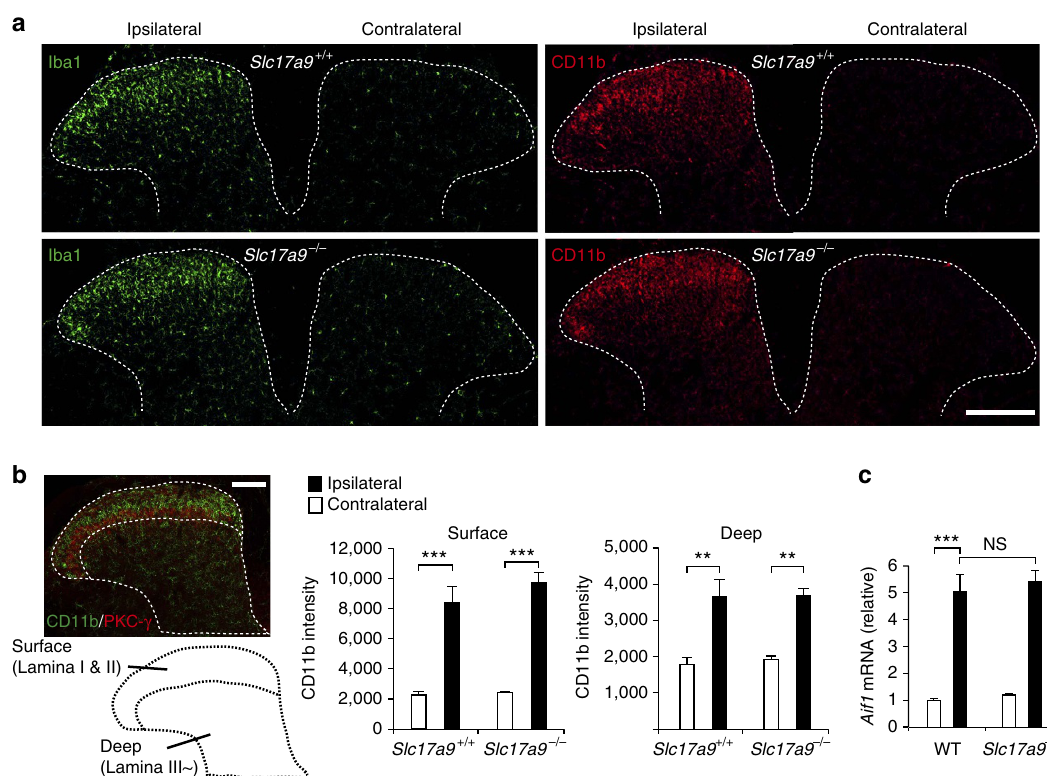
Figure 4 | VNUT is not required for PNI-induced cellular alterations of spinal microglia. ( a ) Representative images showing immunofluorescence labelling of Iba1 (green) and CD11b (red) in the L4 spinal cord of Slc17a9 (cid:2) / (cid:2) and Slc17a9 þ / þ mice 7 days after PNI (scale bar, 200 m m). ( b ) The intensity of CD11b immunofluorescence was quantified for the surface (lateral side of PKC- g signals) and deep (medial side of PKC- g signals) dorsal horn region of Slc17a9 (cid:2) / (cid:2) and Slc17a9 þ / þ mice 7 days after PNI ( n ¼ 4; ** P o 0.01, *** P o 0.001, one-way ANOVA with post hoc Tukey Multiple Comparison test; scale bar, 100 m m). ( c ) Real-time PCR analysis of Aif1 (Iba1) mRNA using total RNA extracted from the spinal cord of Slc17a9 (cid:2) / (cid:2) and WTmice 7 days after PNI. Values represent the relative ratio of Aif1 mRNA (normalized to the value for 18S mRNA) to the contralateral side of WTmice ( n ¼ 6; *** P o 0.001, one-way ANOVA with post hoc Tukey Multiple Comparison test). Values are means ± s.e.m. NS, not significant.